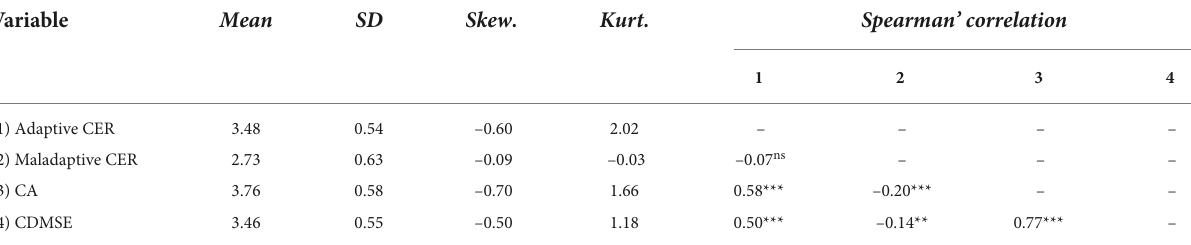
TABLE 1 Descriptive statistics and bivariate correlations of the main variables. Variable